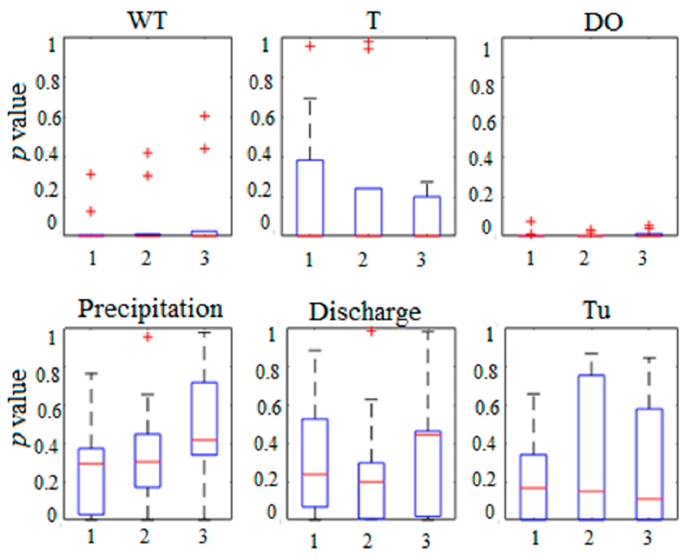
Figure 10. Same as in Figure 7, but for K as an effect in the Granger causality relationship.